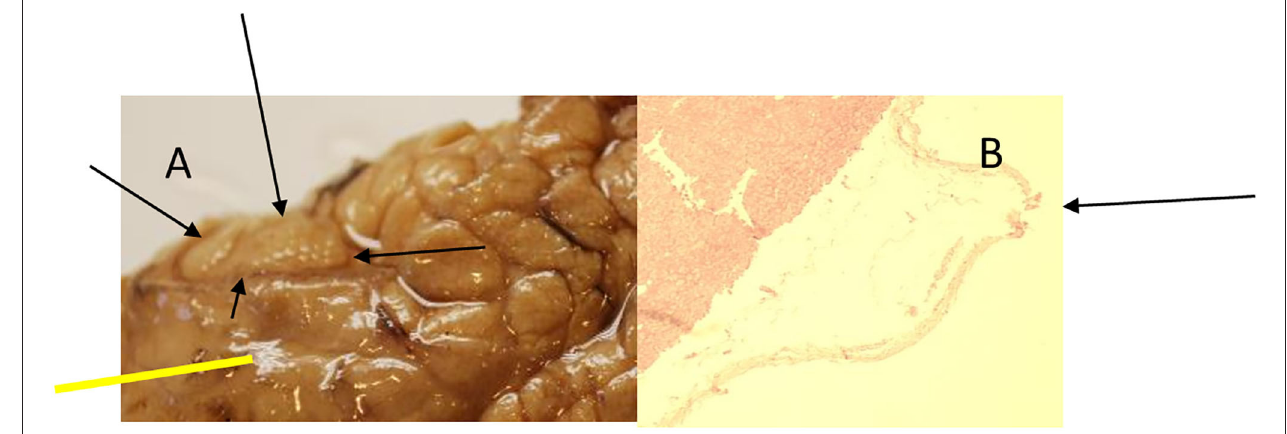
FIGURE 13 | Animal 1, − 80 mmHg. (A) Partial pancreatic resection. Arrows rewrite the section after patch removal with paving stone pattern. Non-patch area marked by bars and with a smooth surface. (B) Pancreas from “Patch” section. Superficial tip-shaped extension of the serosa coating (arrow). All underlying wall layers are regular without pathological changes. No inflammatory